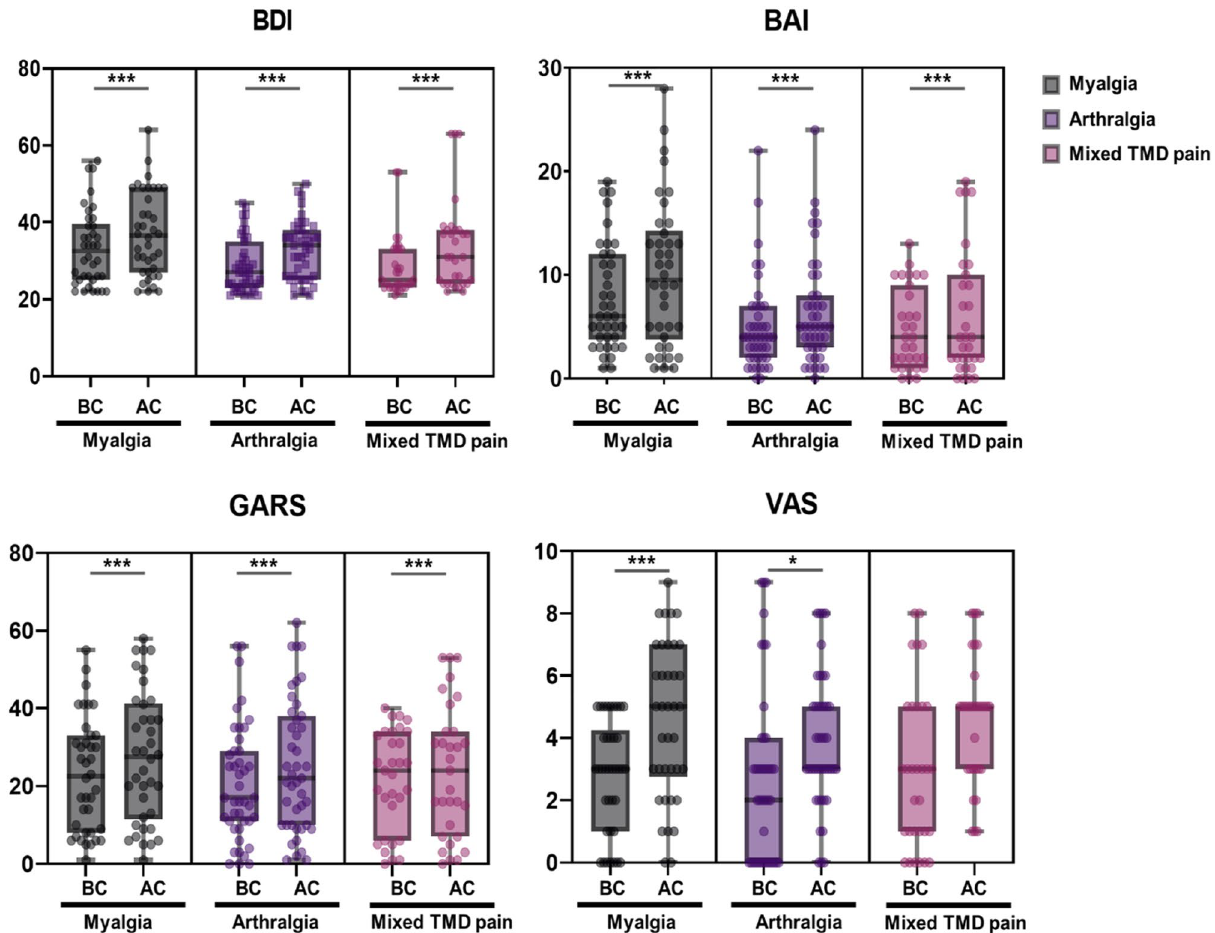
Figure 2. Comparison of Beck Depression Inventory (BDI), Beck Anxiety Inventory (BAI), Global Assessment of Recent Stress (GARS), and Visual Analog Scale (VAS) scores according to TMD pain subgroups. Results were obtained using a paired t-test. Statistical significance was set at p < 0.05. *p < 0.05, ***p < 0.001. TMD, temporomandibular disorder; BDI, Beck Depression Inventory; BAI, Beck Anxiety Inventory; GARS, Global Assessment of Recent Stress; VAS, visual analog scale; BC: before COVID-19, AC: after COVID-19, BC, total score in BC; AC, total score in